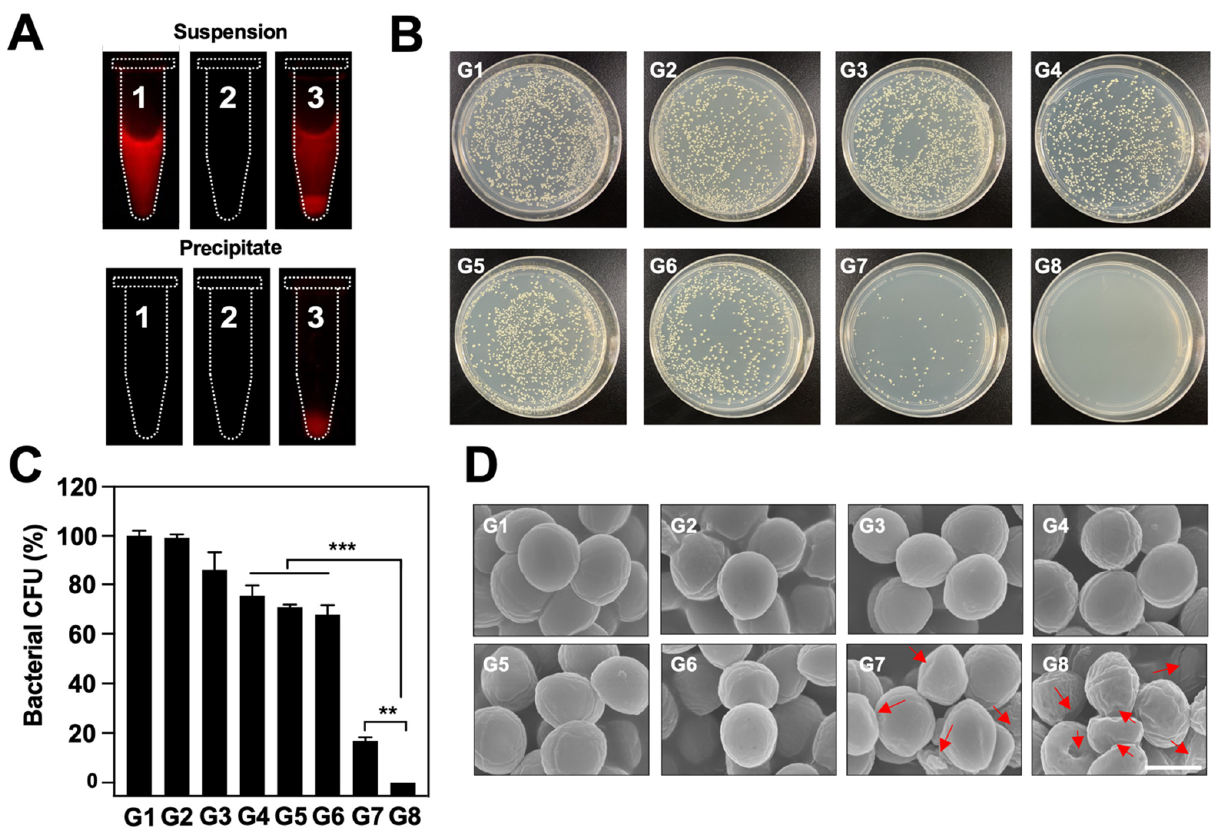
Figure 6. The anti-bacterial efficacy of BSA@Au. ( A ) Observation of BSA@Au binding with MRSA by NIR-II FL imaging. Tube 1, 2, and 3 contained the BSA@Au solution, MRSA solution, and the mixed suspension of BSA@Au and MRSA, respectively. ( B ) MRSA bacterial colonies test on LB agar plates after different treatments. ( C ) Quantification of survival rate of MRSA cells after different treatments. ( D ) Representative SEM images of MRSA exposed to different treatments. The red arrow indicates the crimple, hollow, and crack of MRSA. The scale bar was 1 µm. In ( C , D ), G1: PBS; G2: